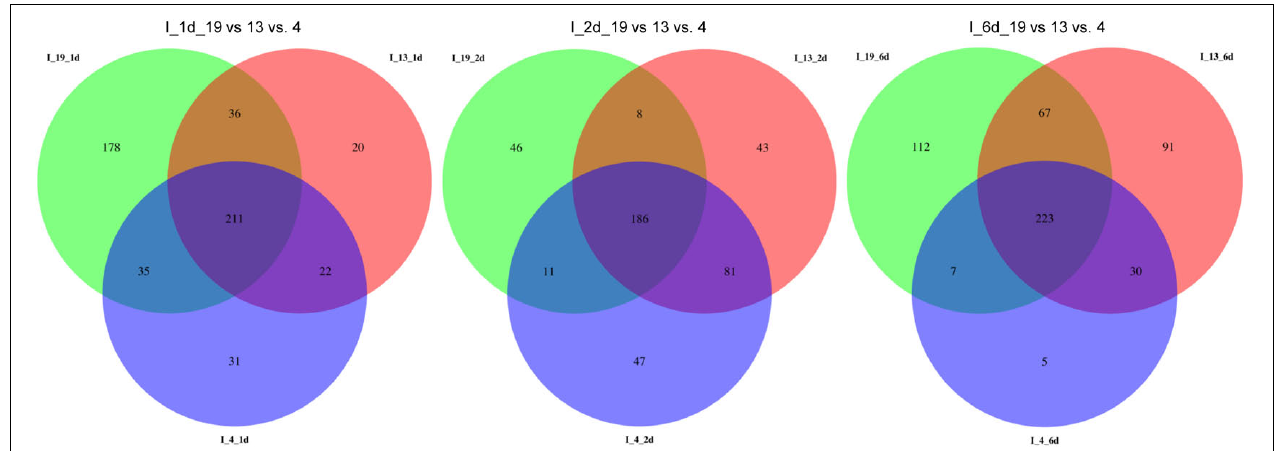
FIGURE 3 | Heatmaps of differentially expressed (DE) miRNAs ( p < 0.01) at (A) 1 dpi, (B) 2 dpi, and (C) 6 dpi in the leaves of BCTV susceptible (Line 19; S) and resistant (Line 13 and Line 4; R) sugar beet lines. Data are Mean ± SE of 3–5 biological replicates.